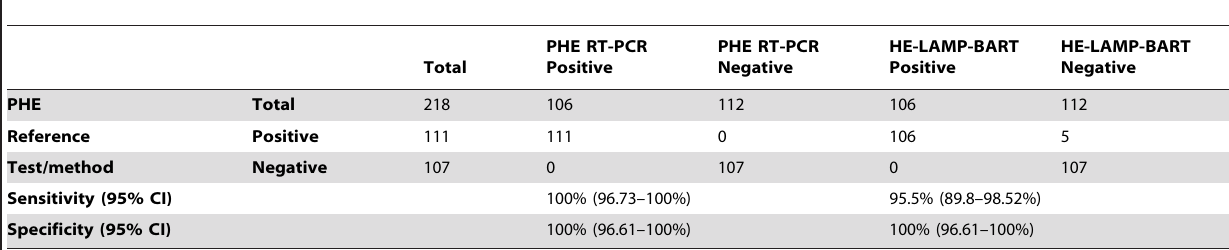
Table 4. Comparison between the reference method and PHE-Cambridge multiplex RT-PCR and